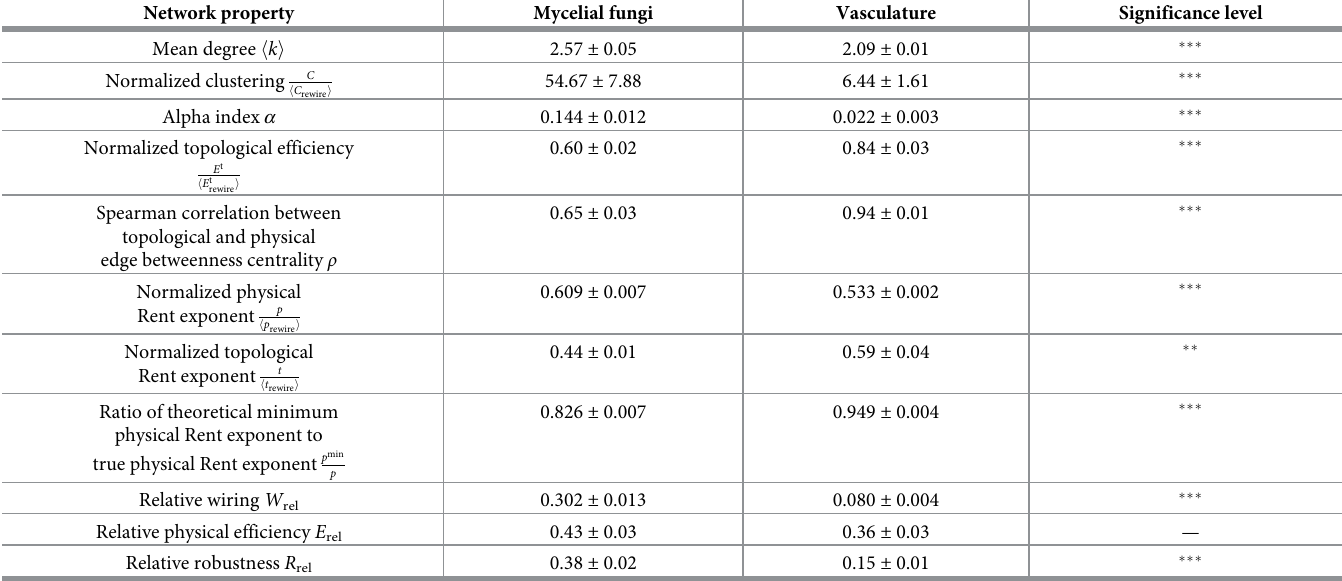
Table 2. Comparison of various network properties between the mycelial and vasculature networks. The first column indicates the network property. The second and third columns give the mean ± the standard error of the mean for each network property, averaged over the population of fungal networks and the population of vascula- ture networks, respectively. The last column indicates the level of significance from a two-sample t -test used to assess statistical differences in the mean values of each net- work property between the two types of distribution networks; (cid:3)(cid:3) p -value < 0.001, (cid:3)(cid:3)(cid:3) p -value <